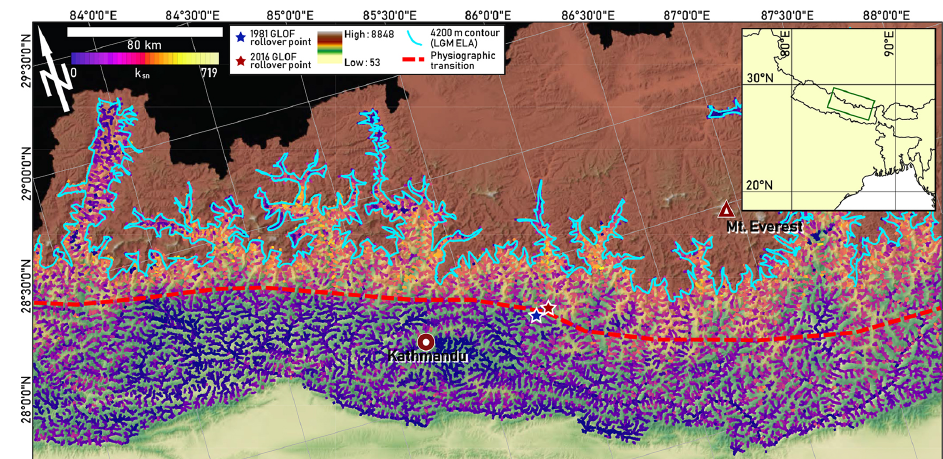
Figure 1. Overview map of the study area, showing equilibrium line altitude at the Last Glacial Maximum (LGM ELA) along with other points of interest. k sn values are overlain on river network for elevations below LGM ELA (Asahi, 2010) and were analyzed only where direct glacial action did not appear to be a major erosion mechanism. PT is assessed visually based on the location of abrupt change in